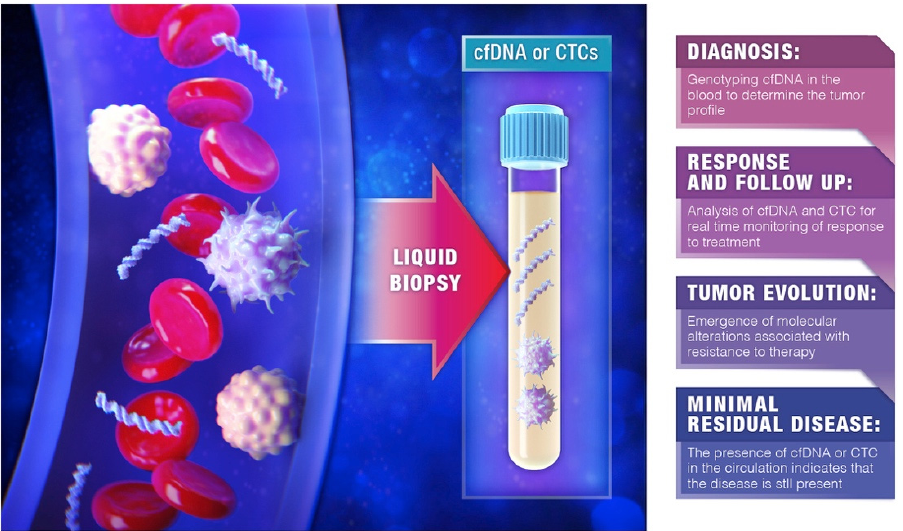
Figure 2. Clinical application of liquid biopsies (Reprinted with permission from Bardelli et al. [39])